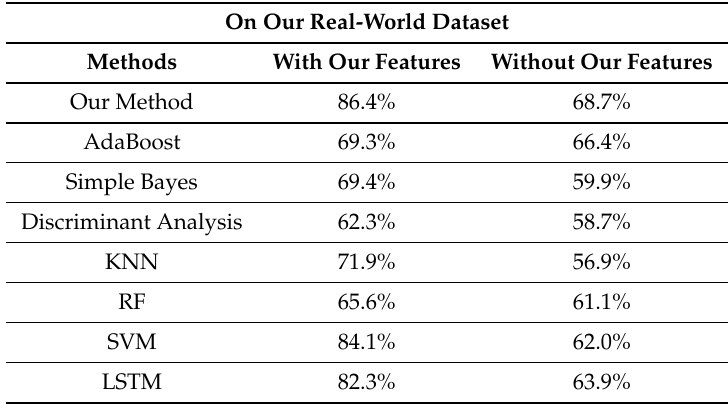
Table 9. Classification accuracies of the eight methods using our real-world dataset. In this experiment for this table, the samples of the training set and test set are collected in four different periods; samples are therefore grouped into four subsets corresponding to the respective time periods.